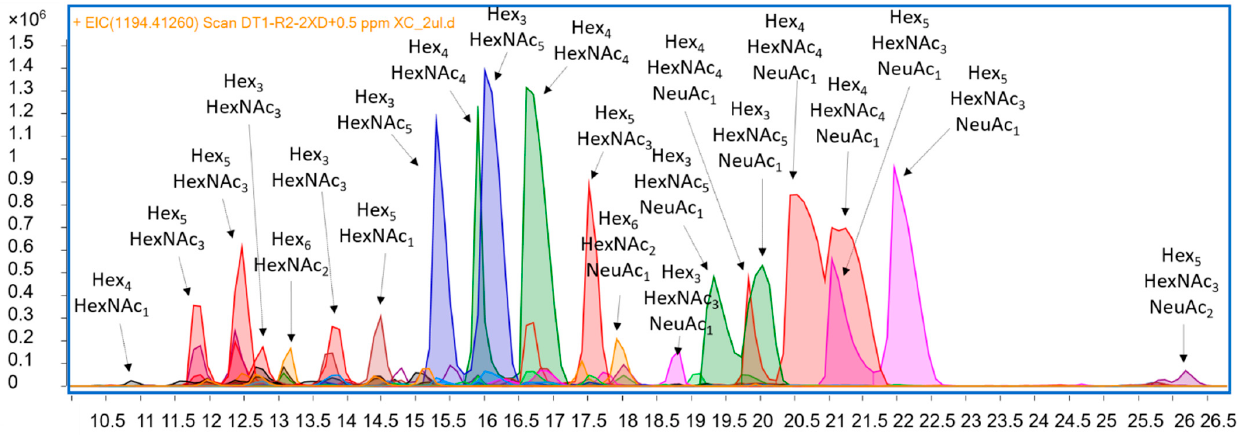
Overlaid extracted ion chromatograms of the most abundant WPPC N-glycans. The N-glycans are denoted by their monosaccharide compositions. Hex: hexose; HexNAc: N-acetylhexosamine; and NeuAc: N-acetylneuraminic acid.